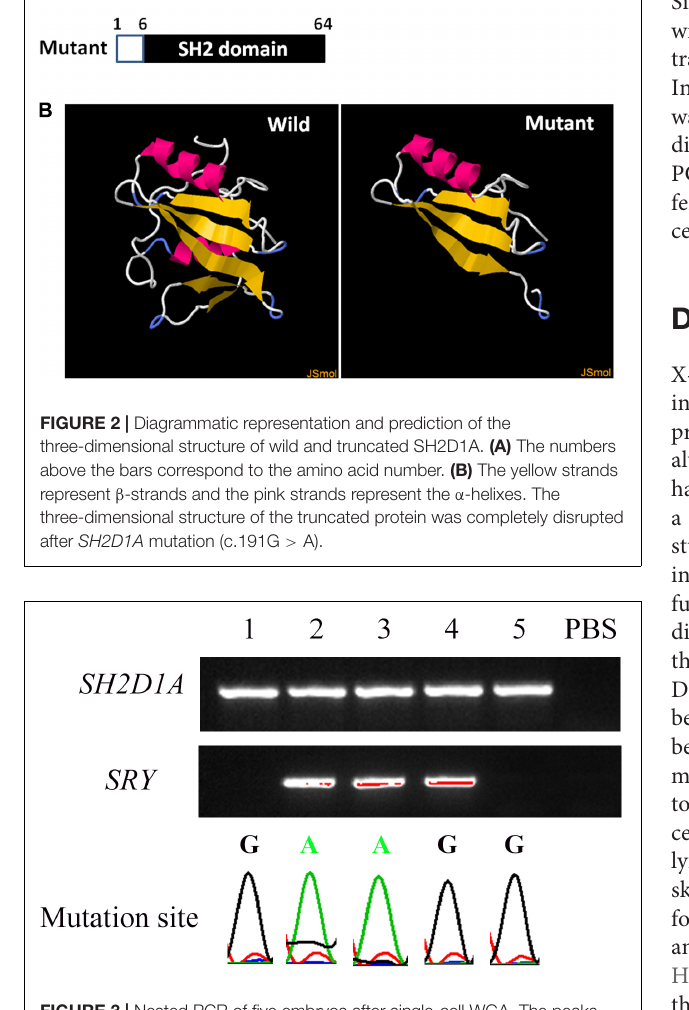
FIGURE 3 | Nested PCR of five embryos after single-cell WGA. The peaks under the bands indicate the corresponding mutation site in SH2D1A . SRY was used to distinguish sex. “PBS” represents the negative control in which PBS was used as a PCR